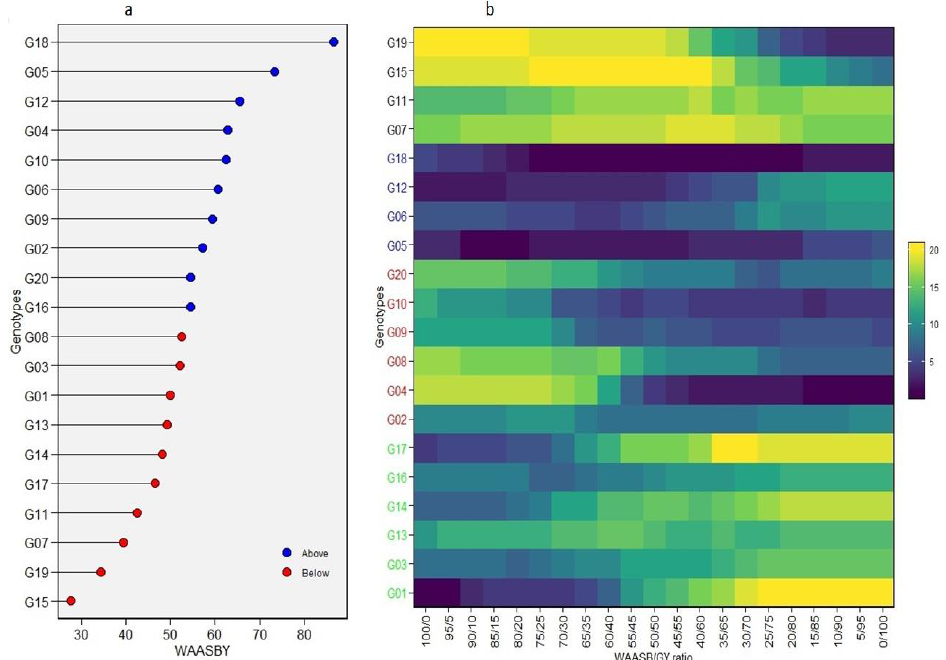
Figure 7. The genotype ranking depending on the weights of the stability and performance. ( a ) Estimated values of the weighted average of stability (WAASB) and mean performance (Y) (WAASBY) for the genotypes considering weights of 50 and 50 for the yield and stability, respectively. ( b ) Ranks of the genotypes considering different weights for the stability and